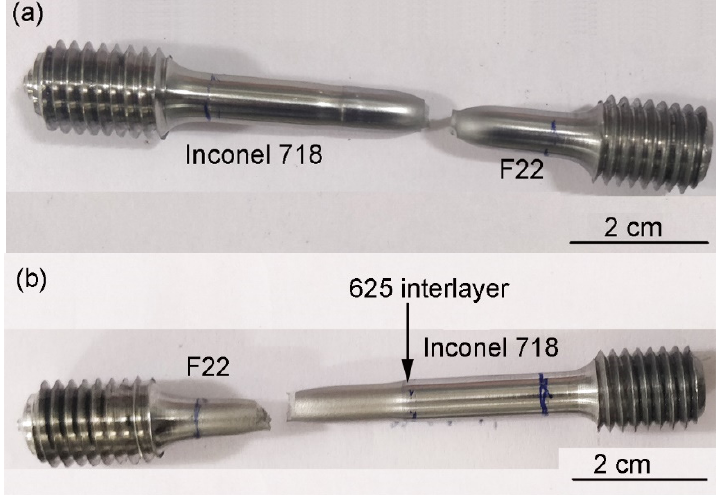
Figure 8. Tensile failure location of the ( a ) 718-F22 friction weld joint and ( b ) 718-F22 friction weld joint with 625 interlayer.